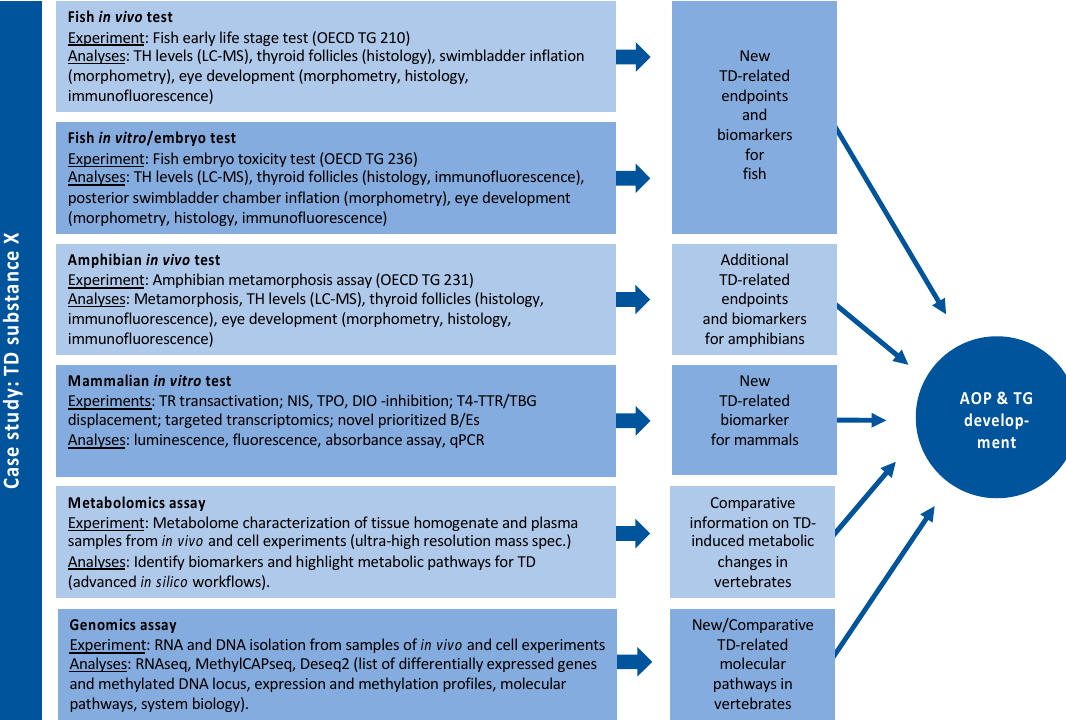
Figure 5. Example of a potential case study in WP5 with compound X.